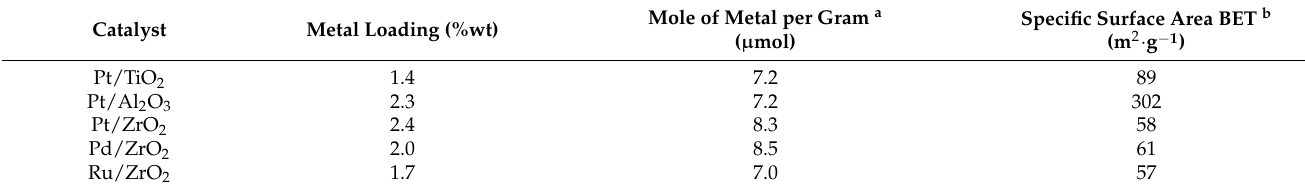
Table 3. Physical and chemical properties of